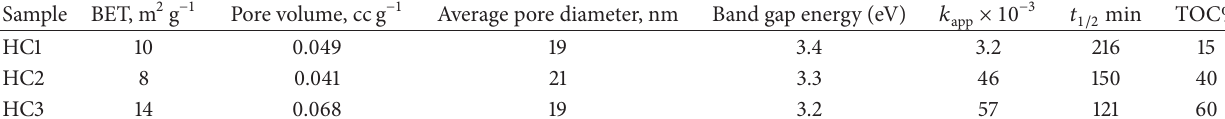
Table 5: Textural properties, band gap energies, and photocatalytic behavior of the calcined materials.